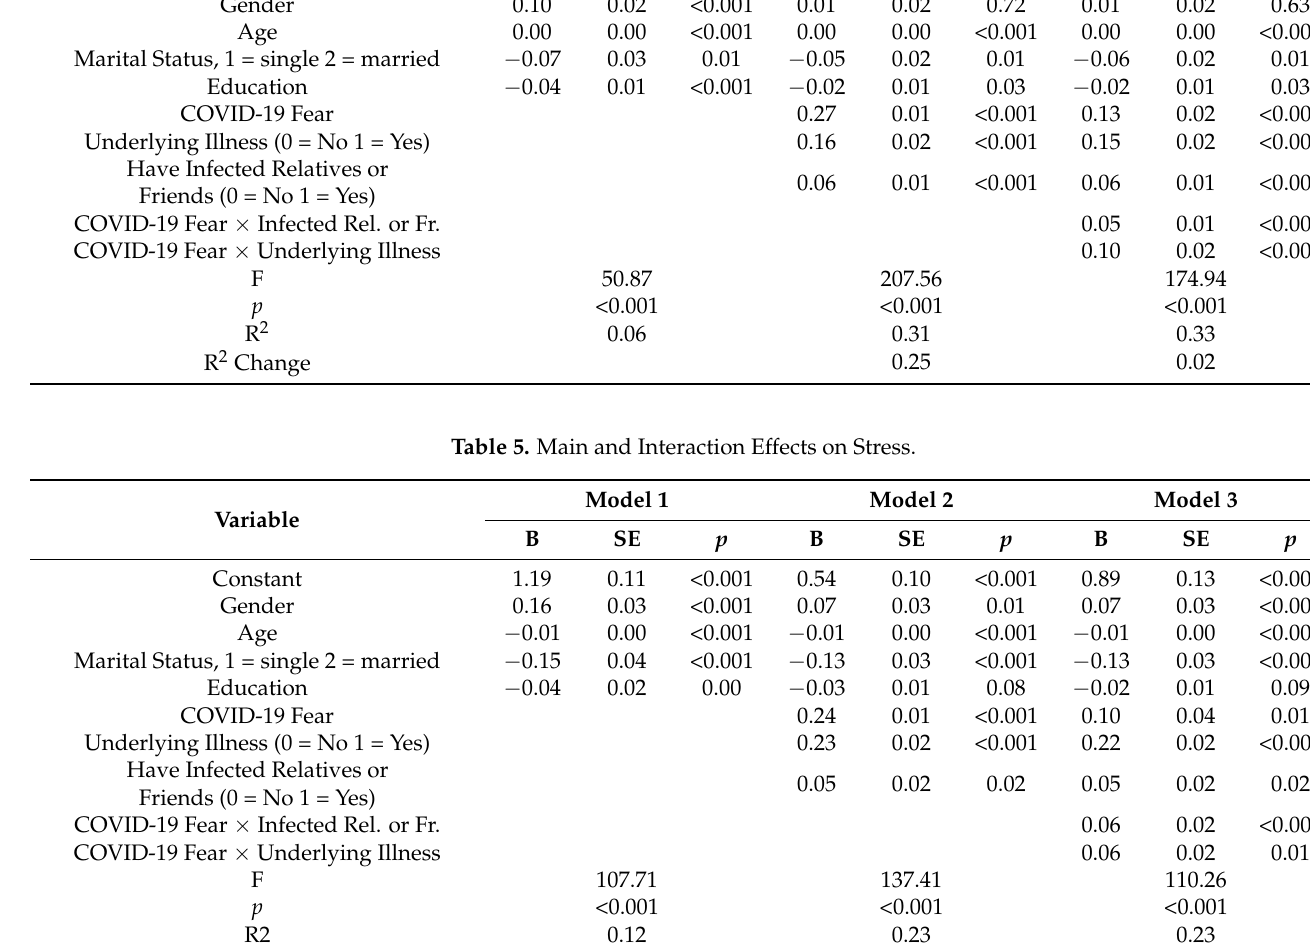
Table 5 (F = 110.26, R 2 = 0.23, ∆ R 2 = 0.01, p < 0.001) were found to be statistically significant. relatives or friends on depression, anxiety, and stress (B = 0.05, p < 0.01; B = 0.05, p < 0.001; B = 0.06, p < 0.001, respectively) was statistically significant. The interaction effect of the (B = 0.09, p < 0.001; B = 0.10, p < 0.001; B = 0.06, p < 0.05, respectively) was